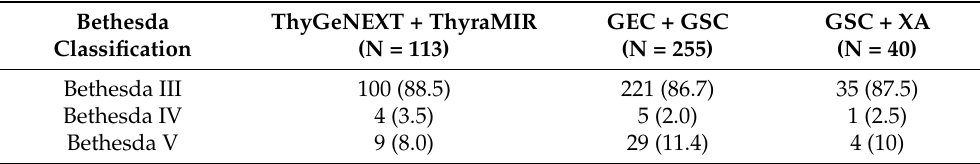
Table 1. Breakdown of molecular testing by the Bethesda classification.